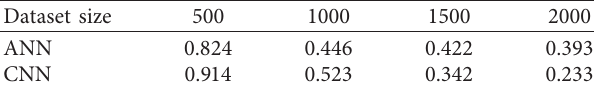
Table 4: The MAPE of two models on the